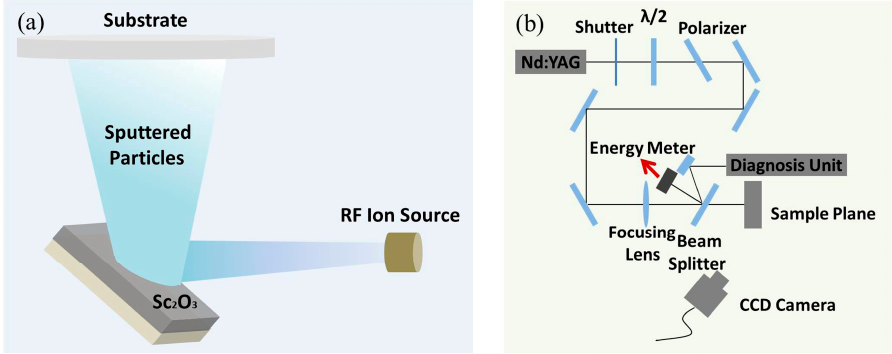
Figure 1. ( a ) Schematic diagram of ion-beam sputtering setup; ( b ) Schematic layout of damage test system.